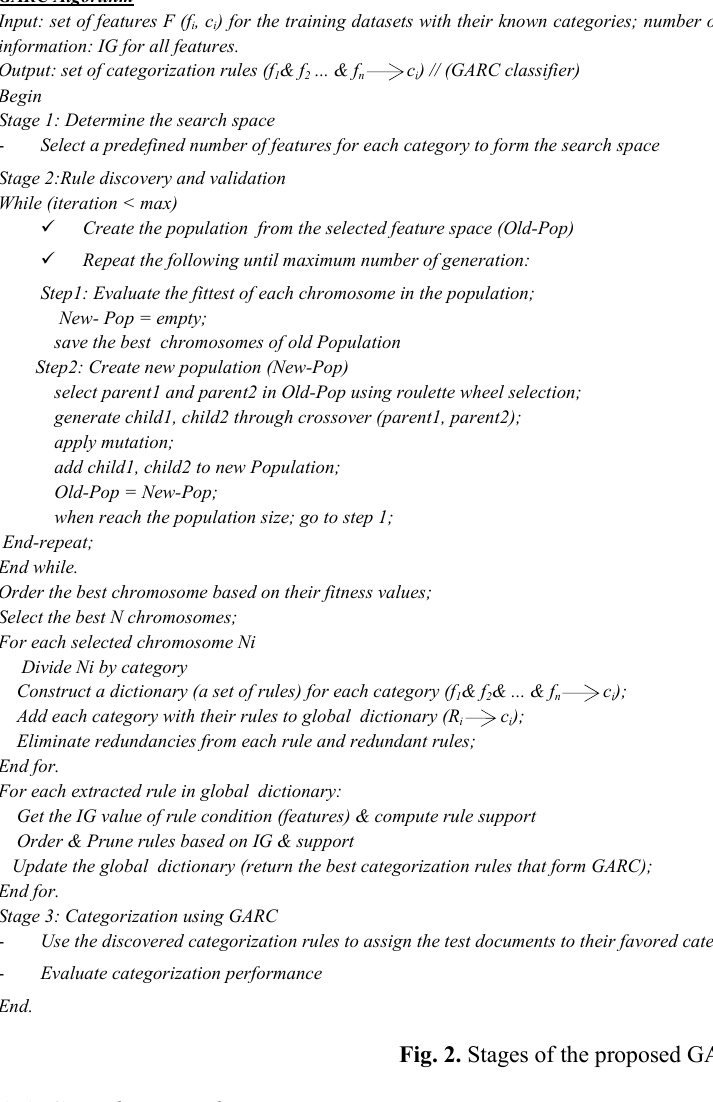
Fig. 2. Stages of the proposed